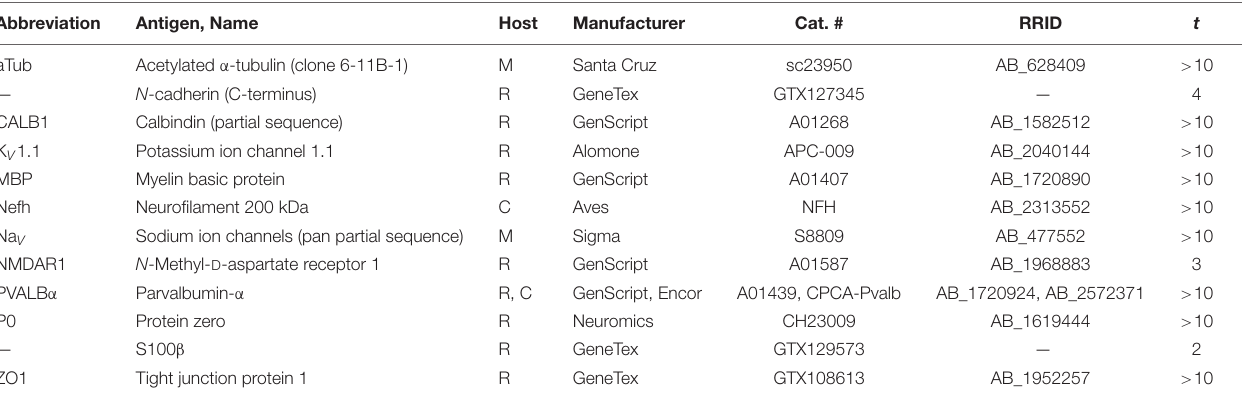
TABLE 1 | Primary antibodies (Ab)